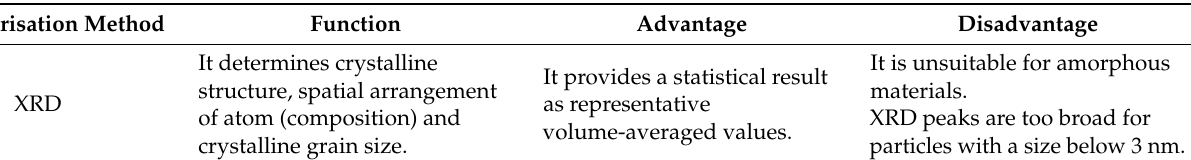
Table 8. A summary of characterisation method of gold nanoparticle, function, advantages and dis- advantages of each method.